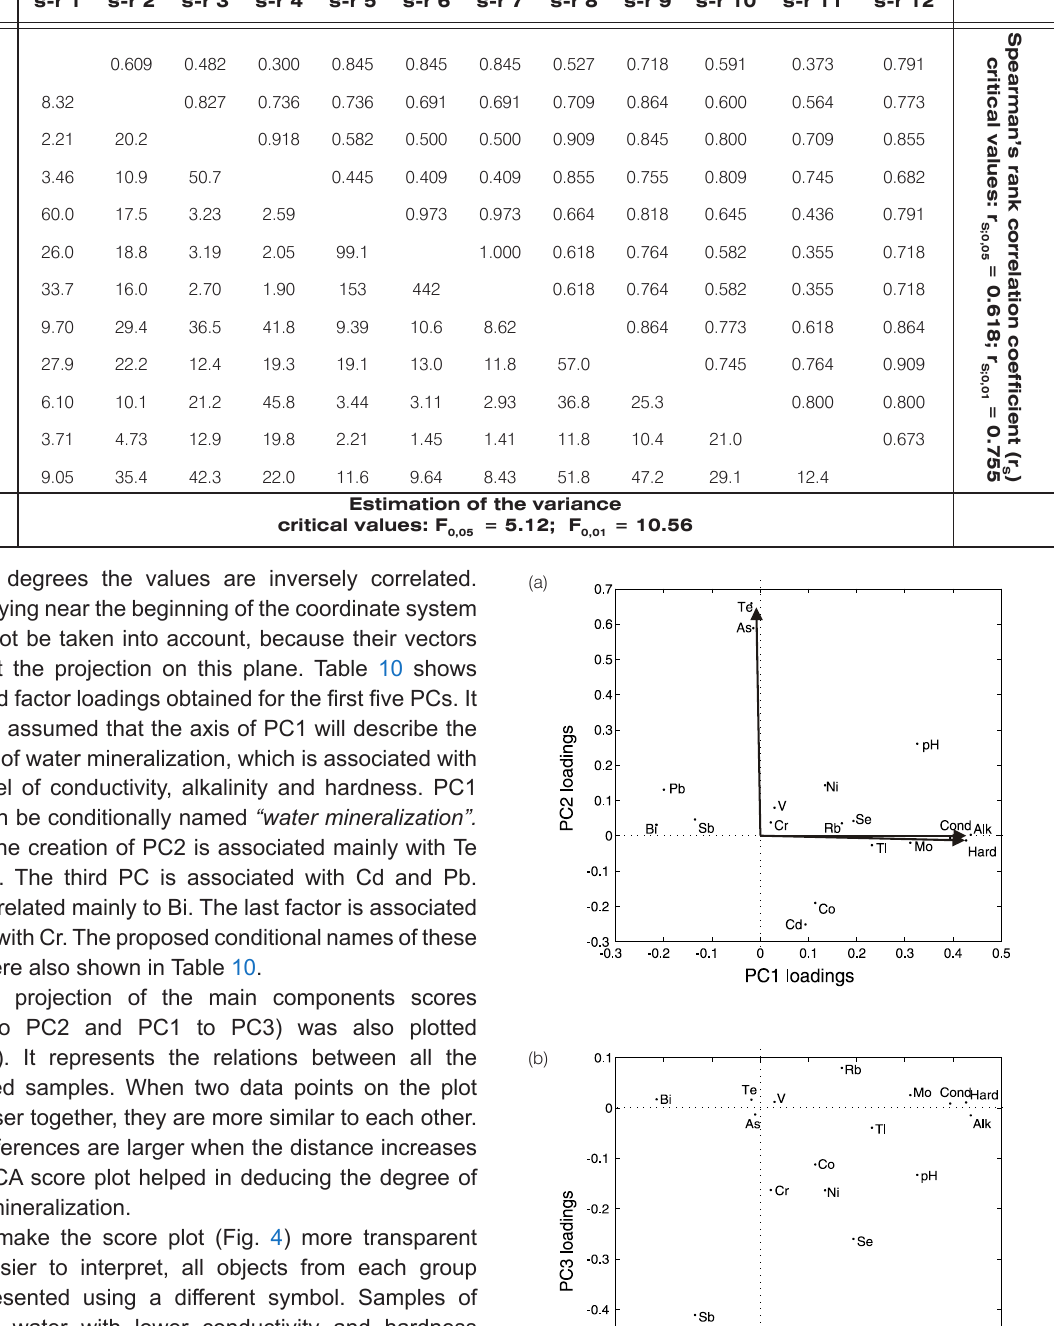
Table 9. Spearman’s rank correlation coefficient and variance correlation test; s-r – sub-region number. s-r 1